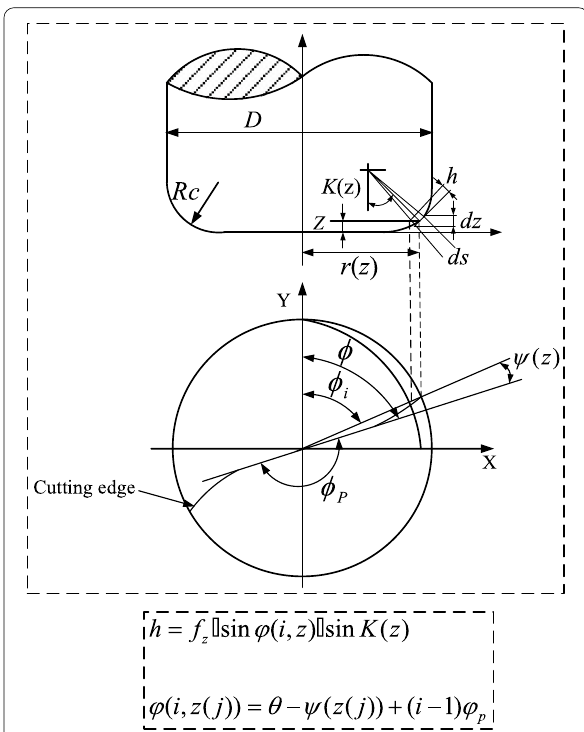
Figure 15 Geometry of cutting edge and load diagram of arc edge milling cutter